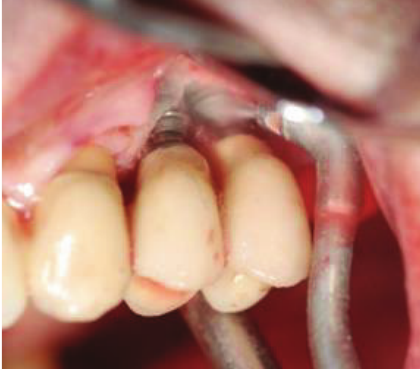
Figure 8: Following decontamination of the implant surface, a mixture of biphasic calcium sulfate and inorganic bovine bone were applied to defect at the buccal and palatal location (without a